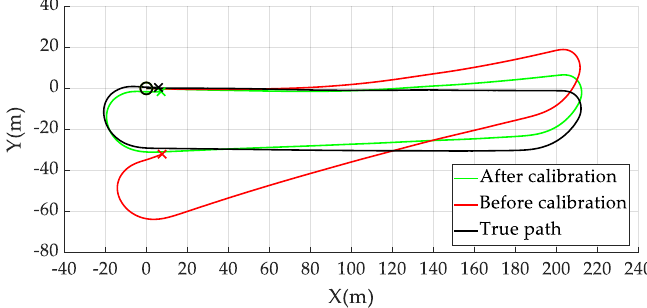
Figure 6. Comparison of the circular driving paths before and after wheel diameter and wheelbase calibration.